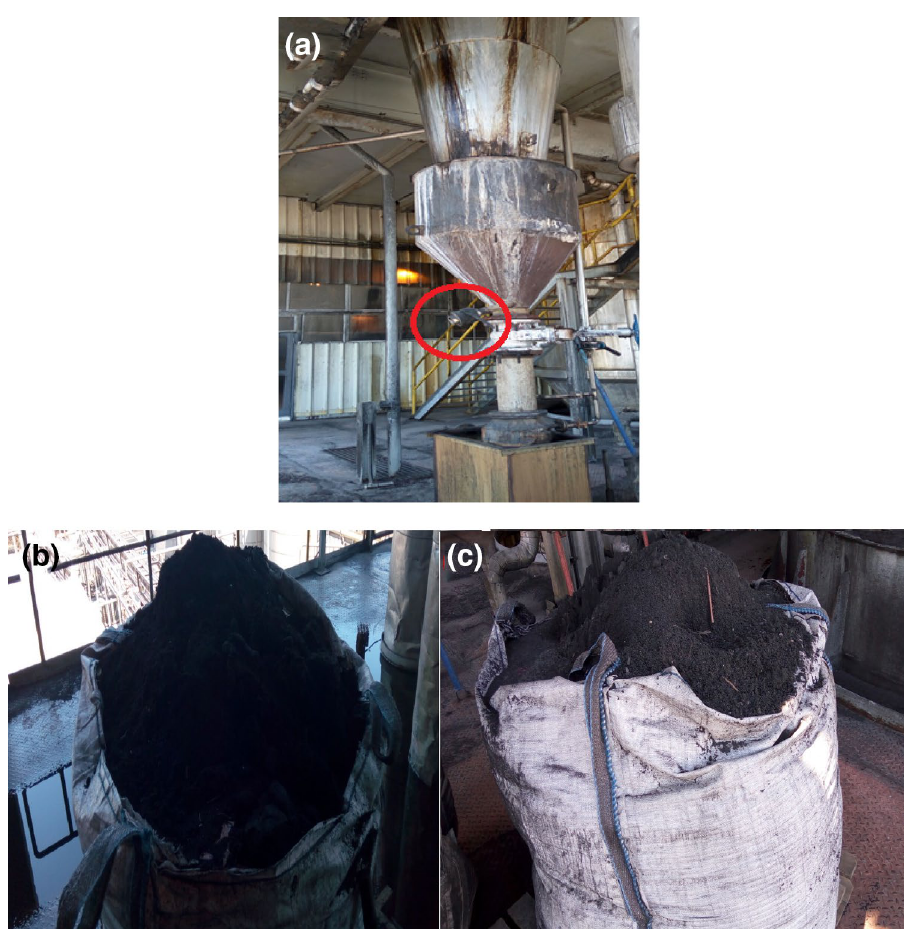
Fig. 2 Cyclone outlet ball valve sample collector ( a ) and the huge PACW ( b , c